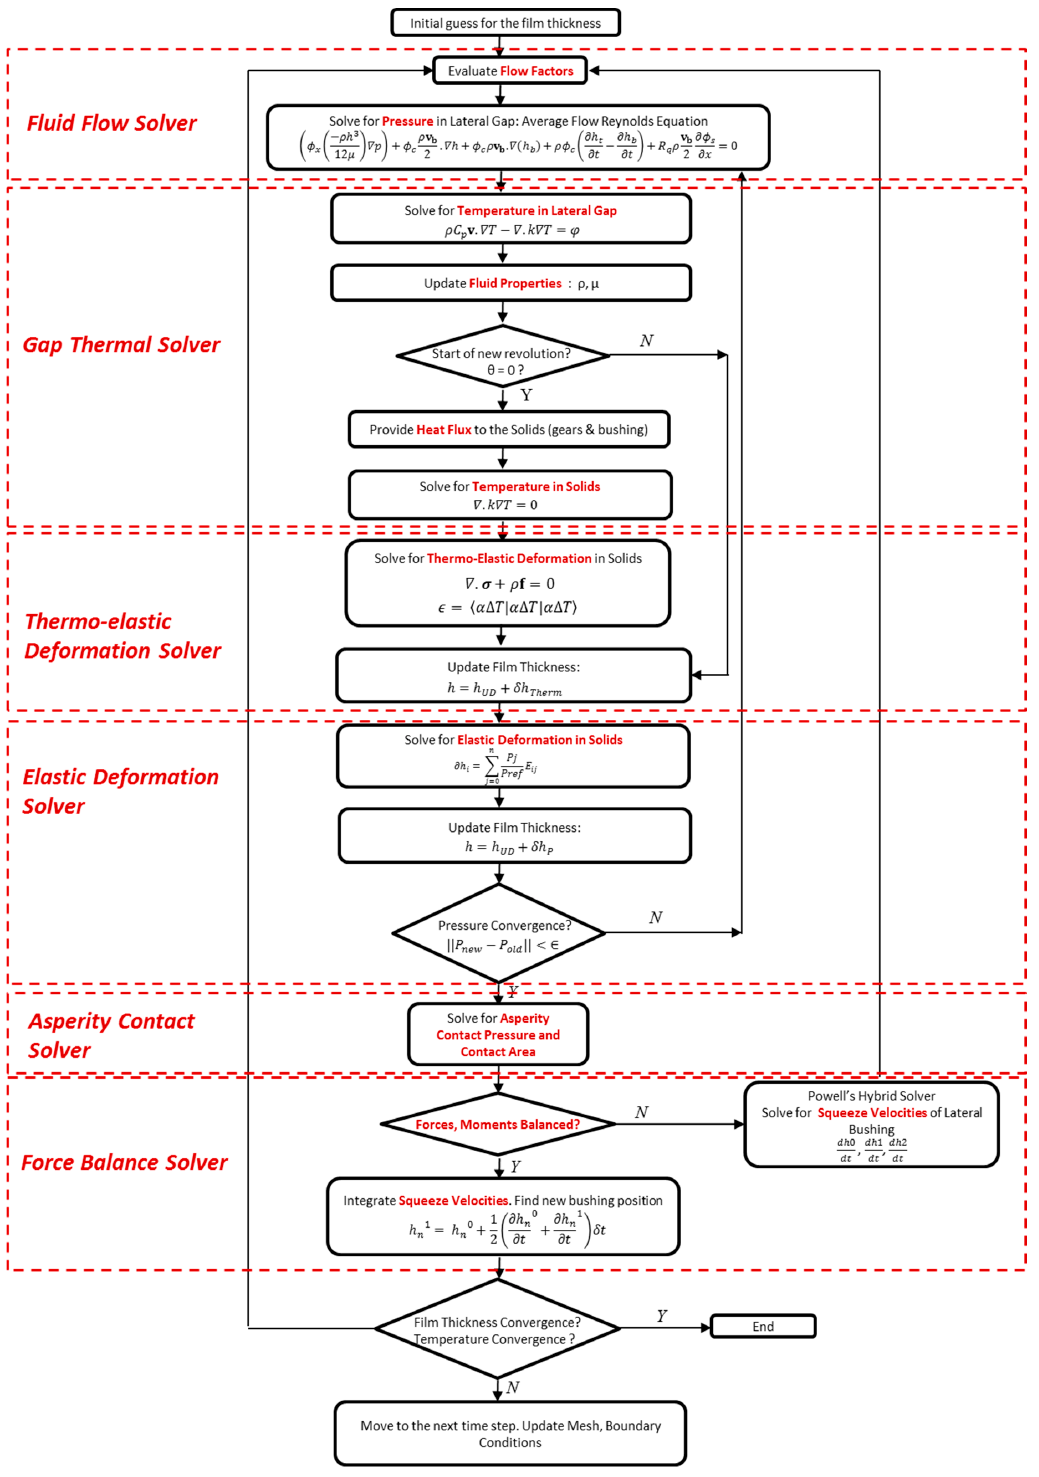
Figure 8. Flowchart representing the numerical scheme implemented in the mixed-TEHD model for the lateral lubricating gaps in